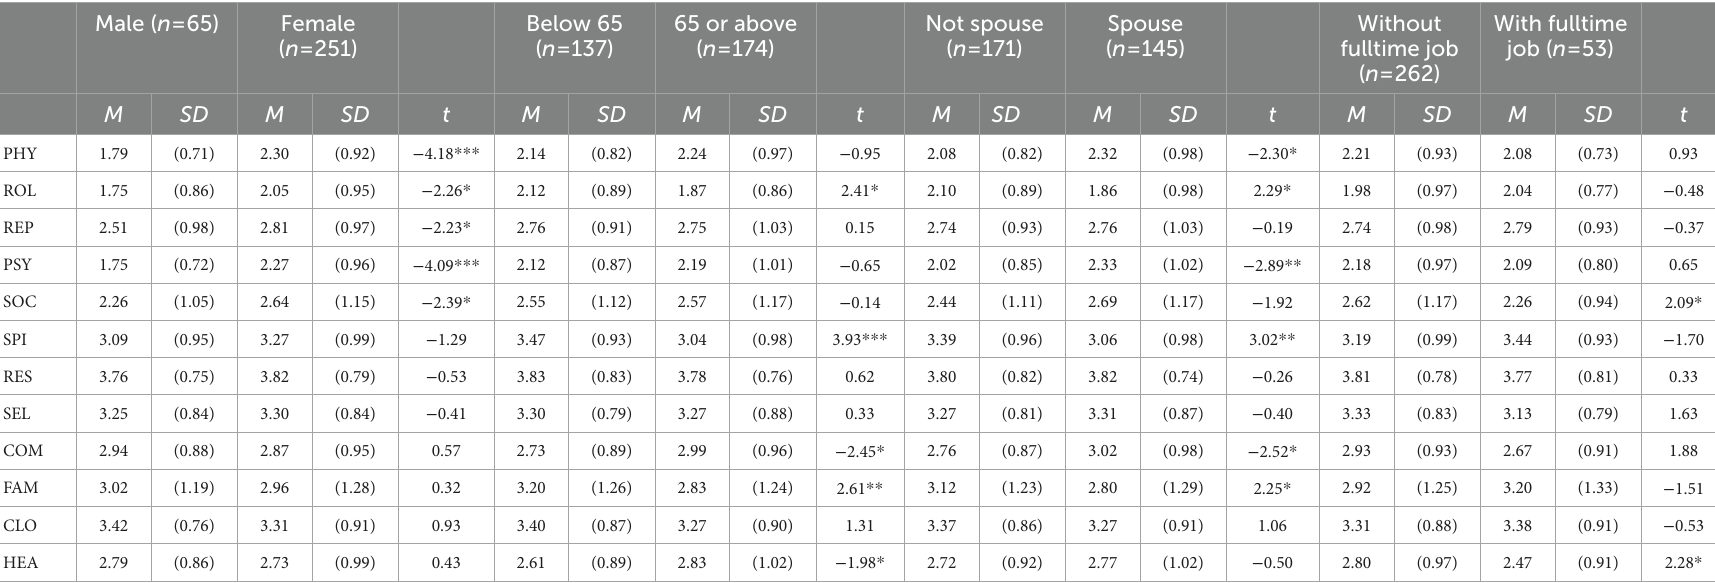
TABLE 4 Mean differences in the caregivers’ needs and resources across demographic groups ( N =